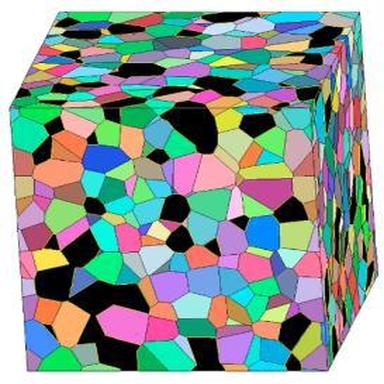
3D Dual Phase (DP) microstructures consisting of 1000 grains. Both microstructures have a second phase volume fraction of 15.6% (indicated in black color). Colors represent crystallographic orientations.